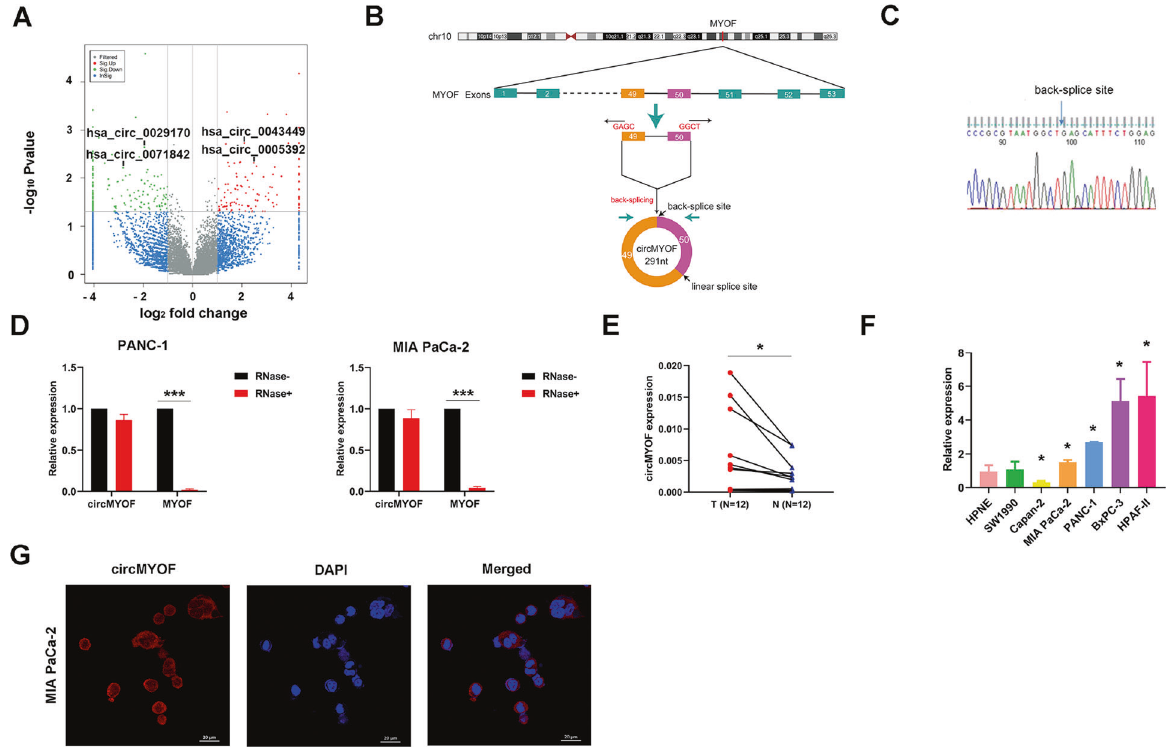
Fig. 1 CircMYOF is upregulated in PDA tissues and cells. A Volcano plot analysis of differentially expressed circRNAs based on RNA sequencing in low glucose-treated and normal glucose-treated MIA PaCa-2 cells. Red plot: differentially upregulated circRNAs; green plot: differentially downregulated circRNAs. A fold change ≥ 2 or ≤ 0.5 and p < 0.05 were considered statistically signi fi cant. B Schematic illustration indicating that circMYOF was formed by the 3 ’ end of exon 50 and the 5 ’ end of exon 49 (black arrow). C Sanger sequencing illustrated that the back splicing site of circMYOF converged with the 3 ’ end of exon 50 and the 5 ’ end of exon 49. D RNase R treatment implied that circMYOF was much more resistant to RNase R treatment than linear MYOF mRNA in MIA PaCa-2 and PANC-1 cells. E Expression levels of circMYOF were measured in 12 PDA clinical tissues and their corresponding adjacent normal tissues by qRT-PCR. F The relative expression of circMYOF in PDA cell lines. CircMYOF expression was increased in most PDA cell lines. G RNA fl uorescence in situ hybridization (FISH) was performed for circMYOF. Nuclei were stained with 4,6-diamidino-2-phenylindole (DAPI); the original magni fi cation was 400×. Scale bars: 20 µm. Data are presented as the mean ± SD of three independent experiments. * p < 0.05, *** p <